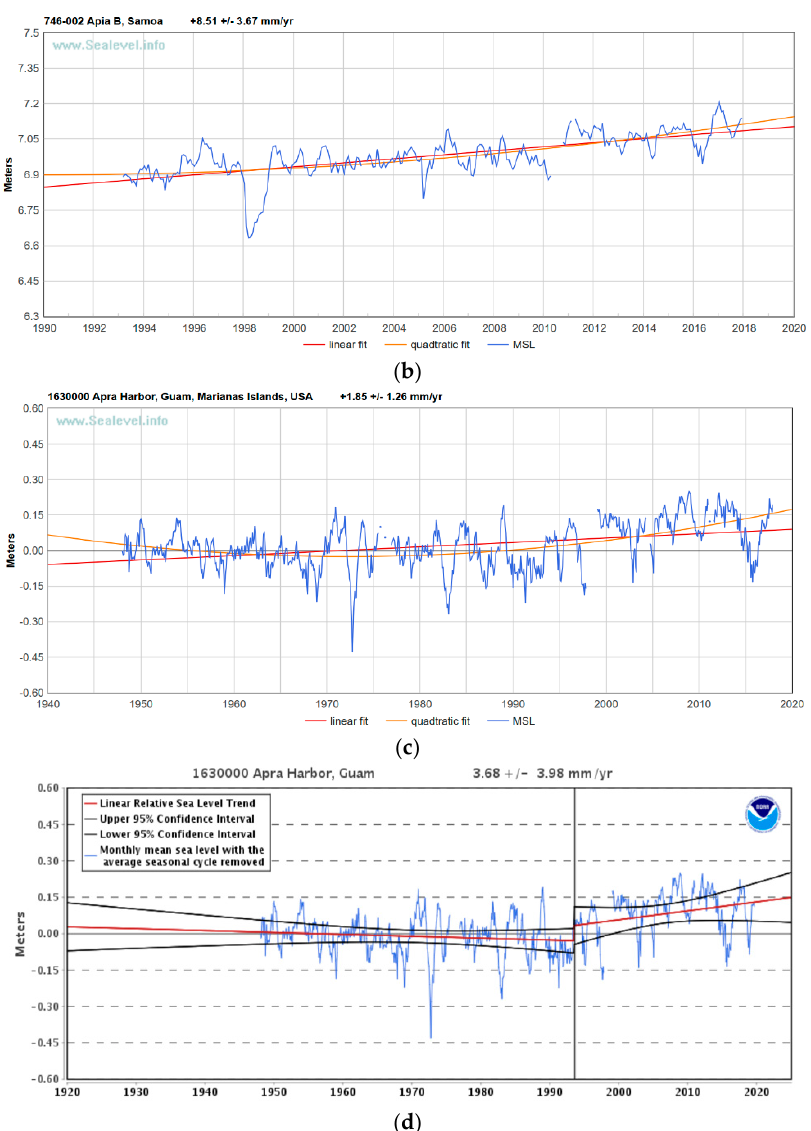
Figure 1. Sample segmented tide gauge records available in databases of tide gauges. MSL (mean sea levels) of Seward ( a ), Apia B ( b ), Guam ( c , d ). Images ( a ) to ( c ) are reproduced and modified from www.sealevel.info. Image ( d ) is reproduced and modified from tidesandcurrents.noaa.gov.